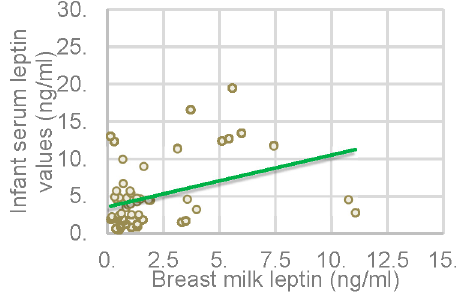
Figure 4. Correlation between breast milk leptin and infant serum leptin values.